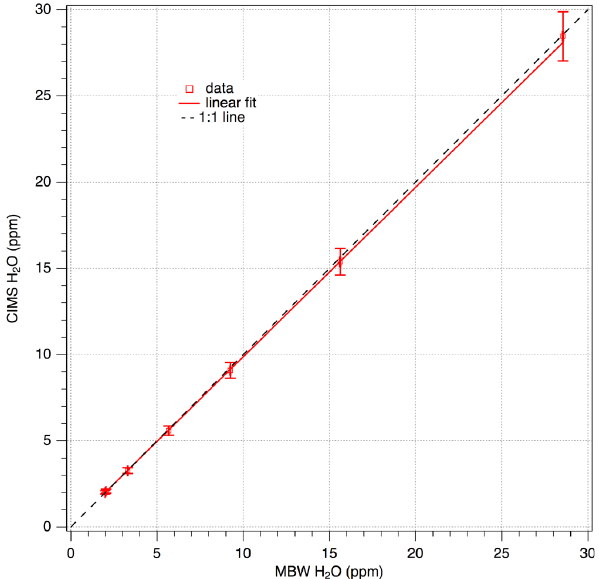
Fig. 8. Comparison of CIMS-measured H 2 O mixing ratios to MBW-measured mixing ratios in a laboratory experiment. The black dashed line is the 1:1 line, and the weighted, orthogonal lin- ear regression fit to the data (red line) is CIMS=0.06 ( ± 0.05)+0.98 ( ± 0.01) ·